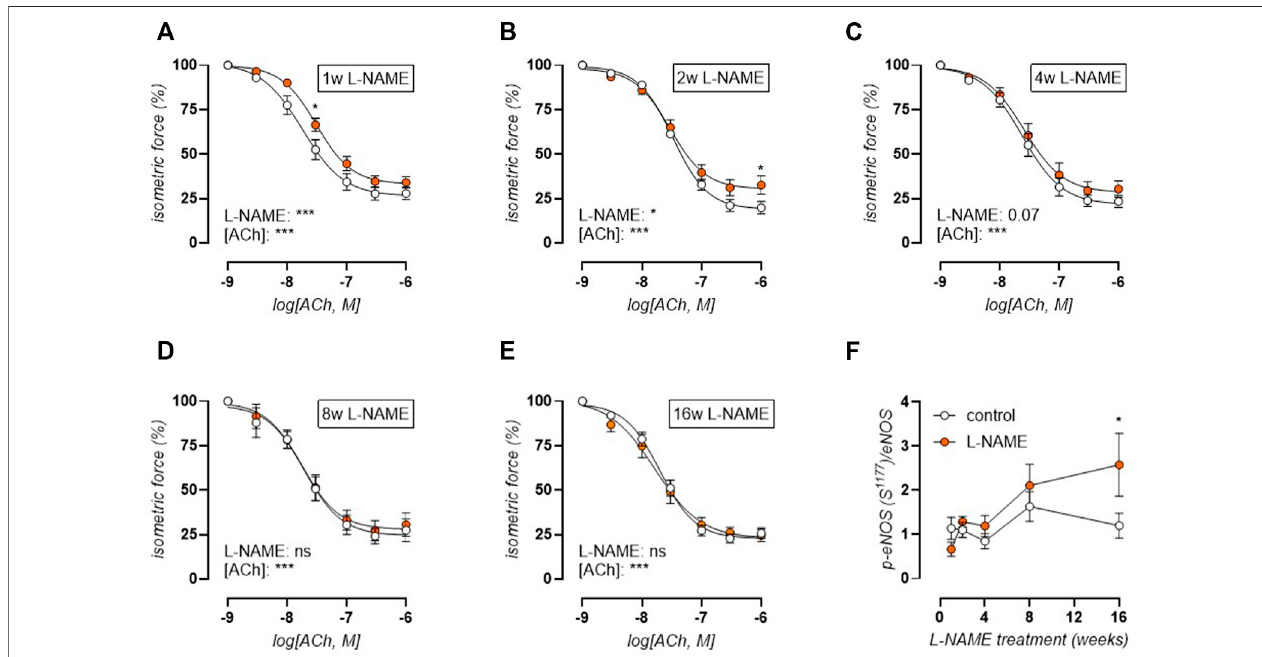
FIGURE 5 | Acetylcholine (ACh) relaxations reveal early endothelial dysfunction and late-term normalization. Concentration-response curves are shown for increasing treatment durations: 1 week (A) , 2 weeks (B) , 4 weeks (C) , 8 weeks (D) , and 16 weeks (E) L-NAME treated (n ≥ 7) and control (n ≥ 9) mice. Western blot analysis (n = 5) of phospho-eNOS (S 1177 )/eNOS (F) . Statistical analysis using two-way ANOVA ( (A-E) , overall signi fi cance: bottom, post-hoc signi fi cance: in graph) or multiple t-tests ( (F) , signi fi cance in graph). * p < 0.05, ** p < 0.01, *** p <